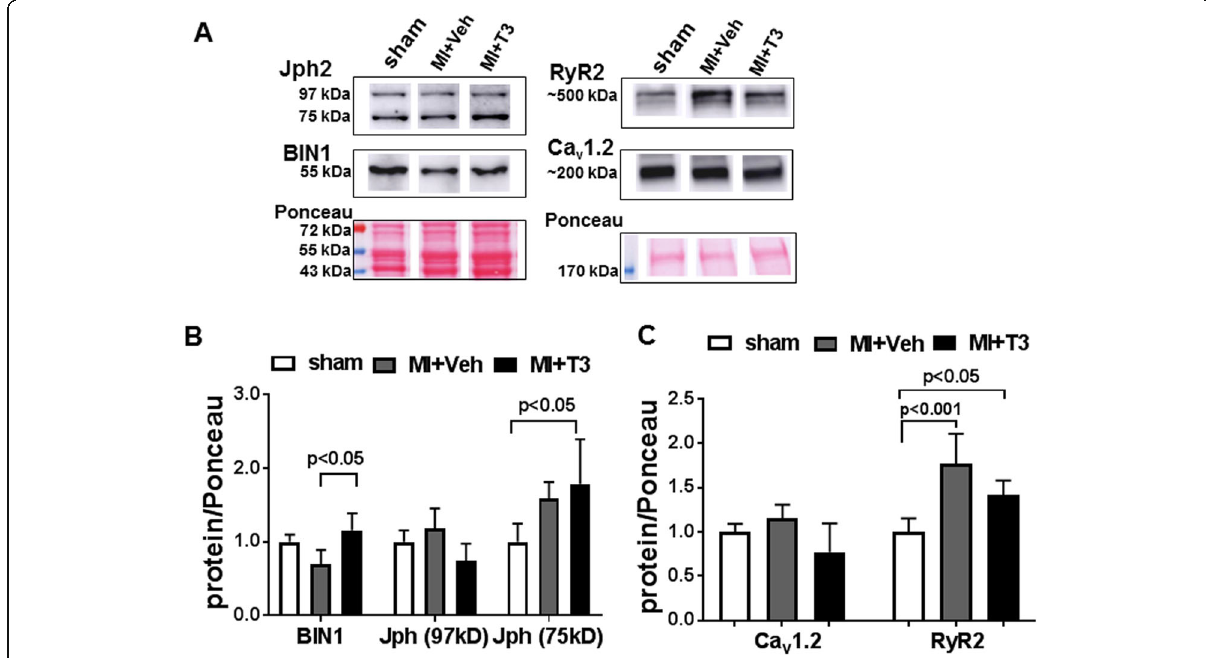
Fig. 6 Immunoblot analysis of T-tubule and SR proteins. a Representative immunoblots of microsomal fractions from LV tissues of each study group that were probed with anti-BIN1, Jph2, Ca v 1.2 and RyR2 antibodies. Observed molecular weights (kDa) of each protein are indicated. Ponceau red staining of the immunoblots are shown with molecular weight markers. b , c Bar graphs show the quantitation of the luminescence intensity of the indicated protein bands, normalized to Ponceau red staining and expressed relative to the mean sham values. Values are mean ± SD for n = 4 – 6 hearts/group. Statistical analysis using one-way ANOVA with post-hoc Tukey ’ s multiple group comparisons; p- values are